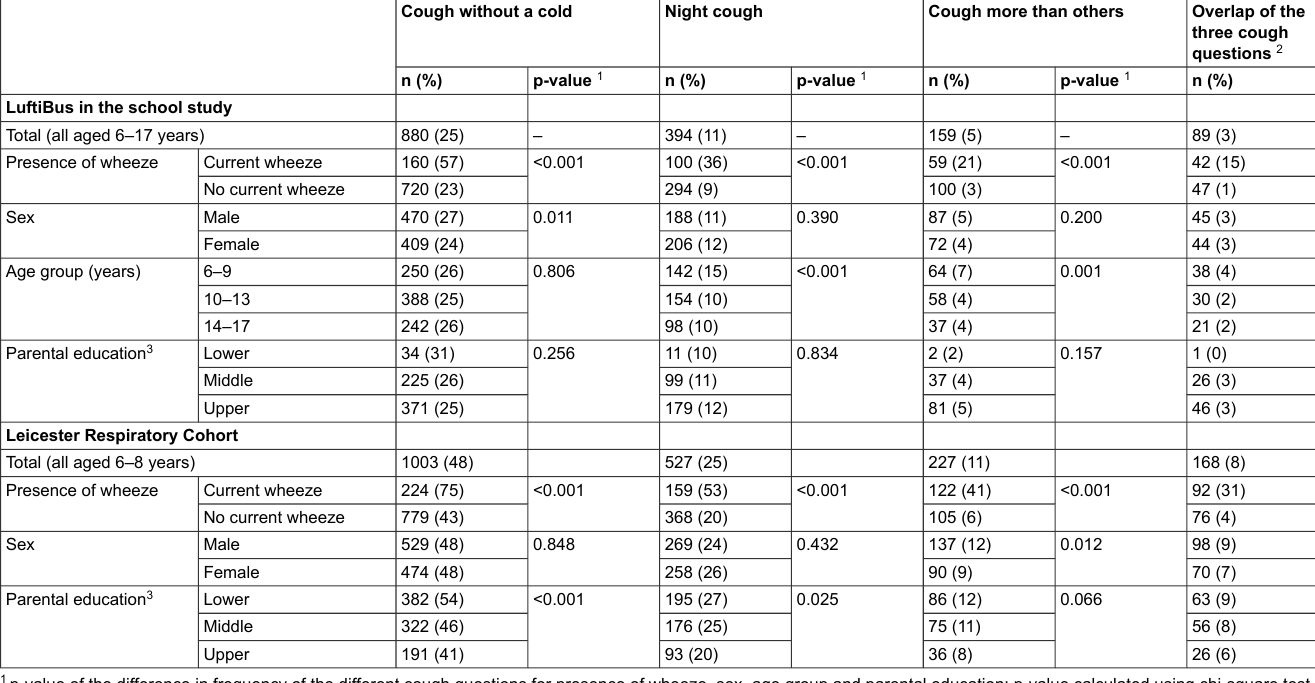
Table 2: Prevalence of cough in school children from the LuftiBus in the school (LUIS) study and Leicester Respiratory Cohort (LRC) based on parents’ answers to differently worded questions stratified by presence of wheeze, sex, age group and parental education level (row percentage). Cough without a cold Night